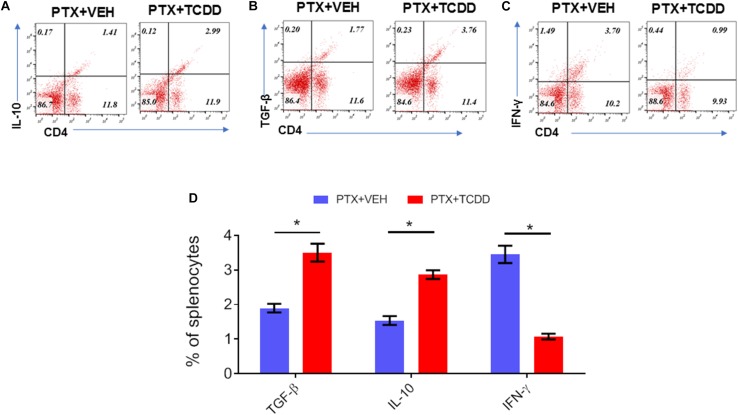
TCDD treatment suppresses PTX-induced Th1 cells and promotes Th2 cells. Mice were immunized with PTX and injected with TCDD as described in the legend of Figure 1. Splenocytes were double-stained for CD4 and various cytokines and analyzed by flow cytometry: (A) IL-10; (B)TGF-β; (C) IFN-γ. Panels A–C show a representative experiment and data from multiple experiments plotted in panel D. Statistical analysis was performed using Student’s t-test. Data are expressed as the mean ± SEM and statistical significance between the two groups is indicated as ∗p < 0.05.